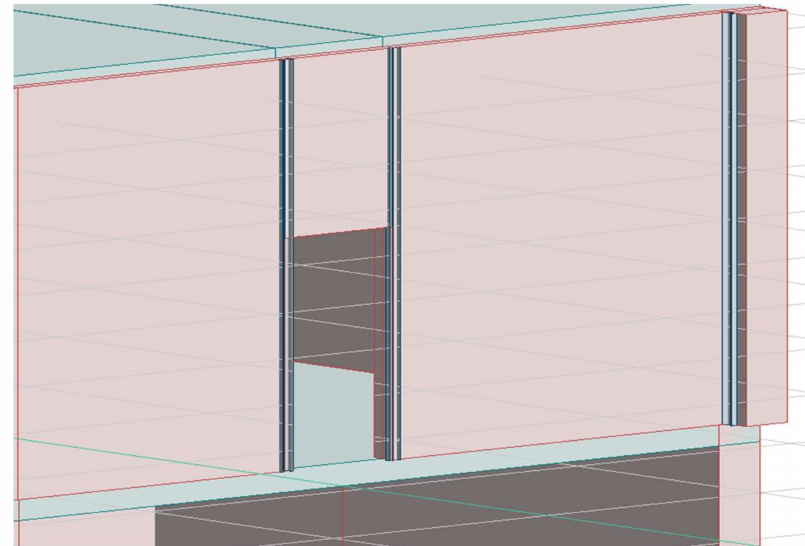
Figure 20. Modeled PSS (U1).